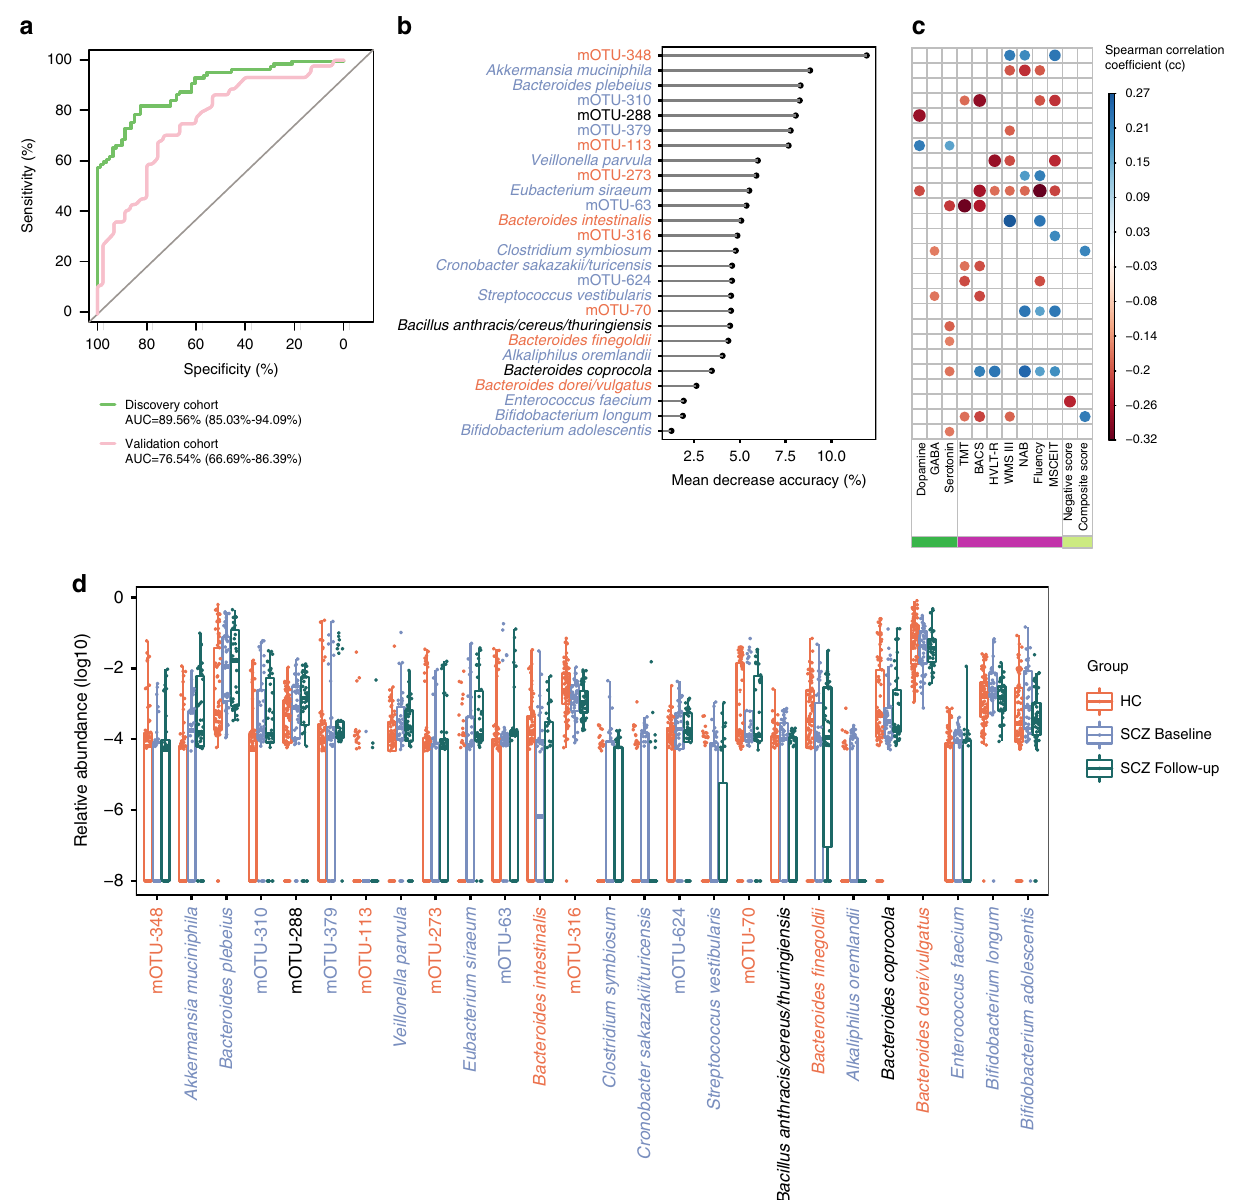
Fig. 3 Gut microbiome-based discrimination between schizophrenic patients and healthy controls. a Receiver operating characteristic curve (ROC) according to 171 samples of the discovery set (green line) and 90 independent validation samples (pink line) calculated by cross-validated random forest models. Area under ROC (AUC) and the 95% con fi dence intervals are also shown. b The 26 mOTUs with most weight to discriminate schizophrenic (SCZ) patients and healthy controls (HC) were selected by the cross-validated random forest models. The length of line indicates the contribution of the mOTU to the discriminative model. The color of each mOTU indicates its enrichment in schizophrenic patients (blue) or healthy controls (red) or no signi fi cant direction (black), respectively. c Spearman ’ s correlation of 26 mOTUs classi fi ers with three types of neurotransmitter in serum (green), seven types of cognitive function evaluated using the MATRICS Consensus Cognitive Battery (purple), and with the positive score and the negative score of the Positive and Negative Syndrome Scale (light green). Only signi fi cant associations are displayed with correlation coef fi cient ( P -value < 0.05). d The relative abundance (log 10 ) of 26 mOTUs classi fi ers in 90 HCs and 38 SCZ patients at baseline and on a follow-up (3 months later). The dot represents one value from individual participants and boxes represent the median and interquartile ranges (IQRs) between the fi rst and third quartiles; whiskers represent the lowest or highest values within 1.5 times IQR from the fi rst or third quartiles. Outliers are not shown. GABA: 4-aminobutyric acid; TMT: Trail Making Test; BACS: Brief Assessment of Cognition in Schizophrenia; Fluency: Category Fluency in Animal Naming; WMS-III: Wechsler Memory Scale-Third Edition for working memory; HVLT-R: Hopkins Verbal Learning Test-Revised for visual learning; NAB: Neuropsychological Assessment Battery for reasoning and problem solving; MSCEIT: Mayer-Salovey-Caruso Emotional Intelligence Test for social cognition. See detailed statistical data in supplementary Source Data fi